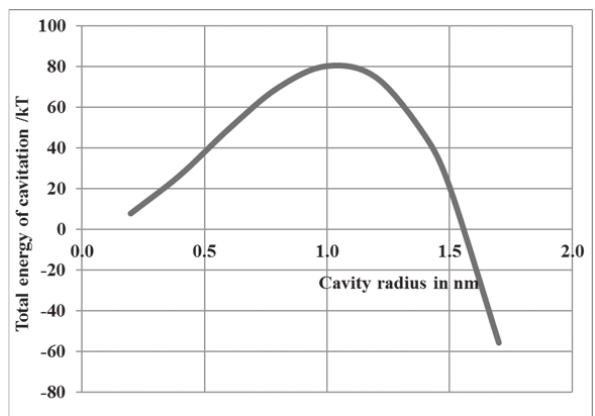
Figure 2. Theoretical calculation of the energy (in kT units) required to form a spherical cavity of radius r in pure water under ideal, de-gassed conditions, in the absence of nucleation sites, with an applied suction pressure of -1400 atm.